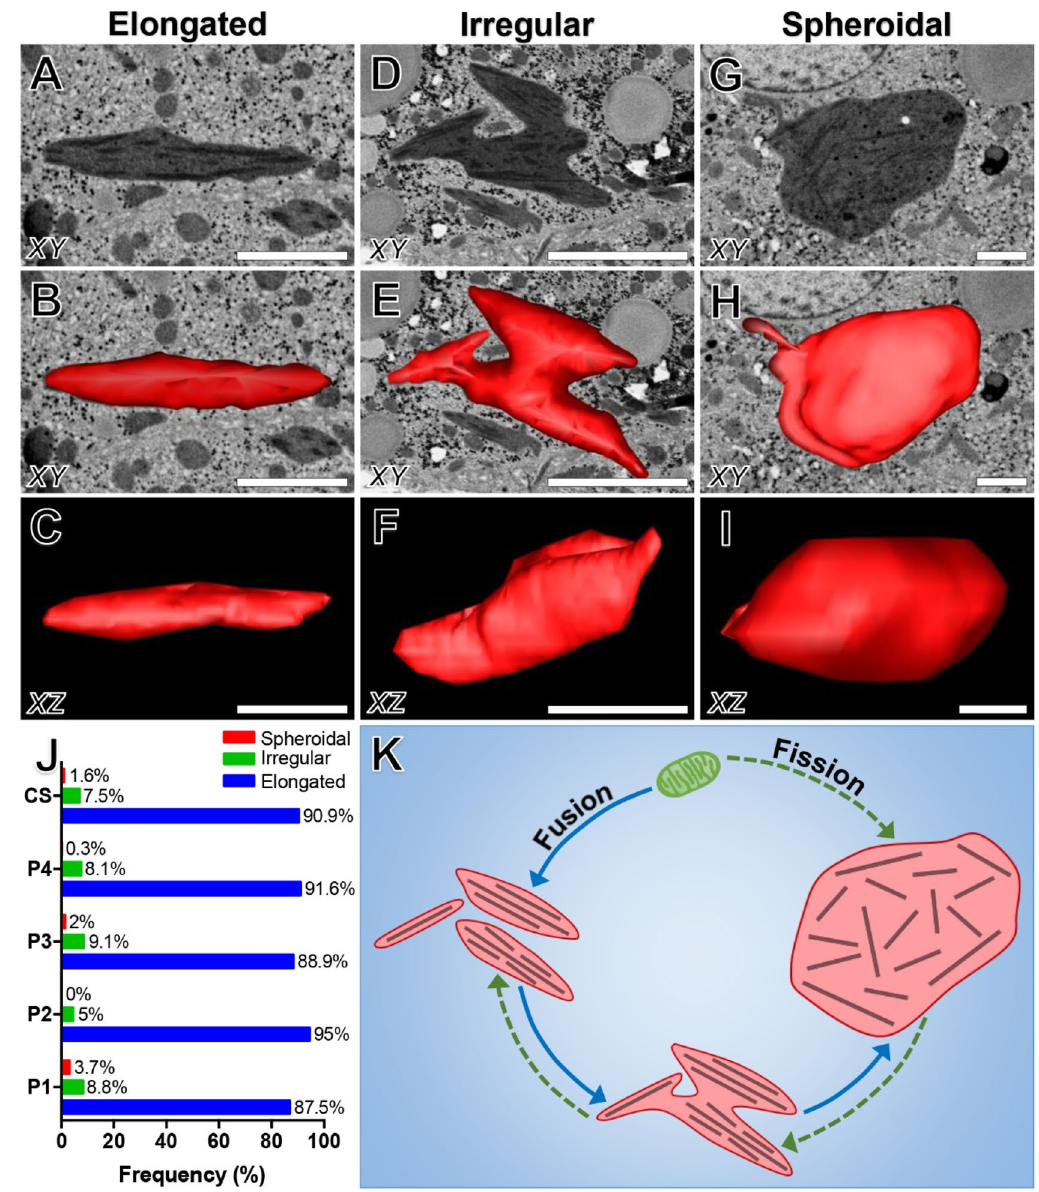
Figure 4. A comparative overview of the three most common giant mitochondria morphologies, and proposed mechanism for their formation. ( A–C ) Elongated mitochondria revealing a spindle or rod-shaped morphology. They are characterised by ICIs arranged parallel relative to the longitudinal axis of the mitochondrion. ( D – F ) Irregular mitochondria displaying a branching or stellate morphology in which ICIs are oriented parallel to the longitudinal axis of the various branching/fusing segments. ( G – I ) An enormous spheroidal giant mitochondrion displaying a globose morphology in which numerous mitochondrial inclusions are visible throughout the matrix, and ICIs are oriented with no particular directionality. ( J ) Quantitative comparison of the relative frequency of elongated, irregular and spheroidal giant mitochondria amongst the four patients. Legend: P1-4, Patient 1–4; CS, indicates the combined score for all patients. ( K ) Proposed mechanism for the formation of giant mitochondria. Giant mitochondria may form by either fusion (blue arrows) of elongated mitochondria or fission of spheroidal mitochondria (green dotted arrows), or both. Fusion involves initial degeneration of normal mitochondria, accompanied by disorganisation of cristae and the parallel alignment of ICIs relative to the longitudinal axis, to form elongated mitochondria. Next, multiple elongated mitochondria aggregate and fuse to form irregular mitochondria, in which ICIs are arranged parallel relative to the longitudinal axis of each branching/fusing segment. Irregular mitochondria appear to accumulate additional degenerative alterations, and in so doing enlarge to form spheroidal mitochondria, which are characterised by paucity of the cristal membrane and a random arrangement of ICIs throughout the mitochondrial matrix. The proposed mechanism for giant mitochondria formation via fission (green dotted arrows) involves gross enlargement of normal mitochondria into spheroidal mitochondria. These may rearrange into branching profiles (irregular mitochondria), which then may divide into multiple elongated mitochondria. Based on ultrastructural observations and frequency measurements, the mechanism for mitochondrial fission as the primary mechanism for giant mitochondria formation seems unlikely, however cannot be excluded. Scale bar: 3